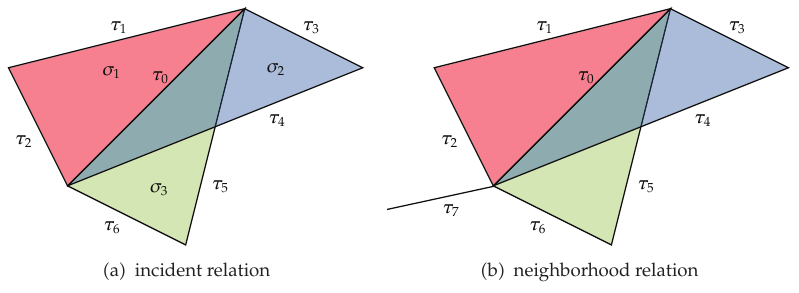
Figure 1: An attractor model on simplicial